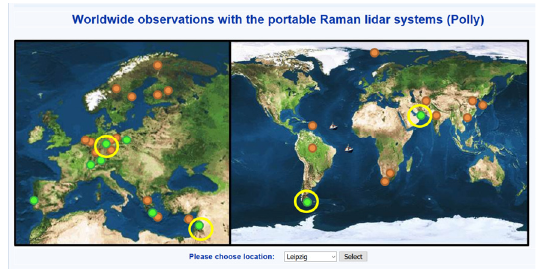
Fig. 3: Map of PollyNET showing active (green) and past (orange) locations. Stations for Aeolus Cal/Val are marked with a yellow circle. (cid:2)